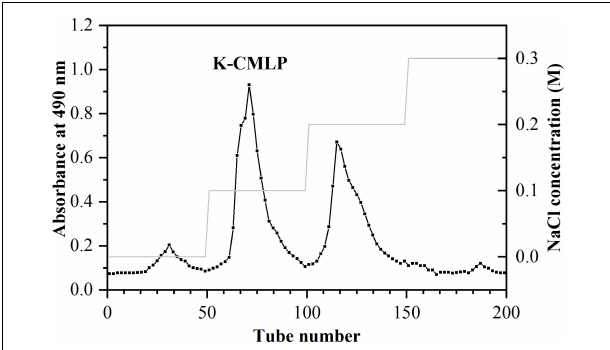
TABLE 1 | Composition analysis of bergamot polysaccharide.